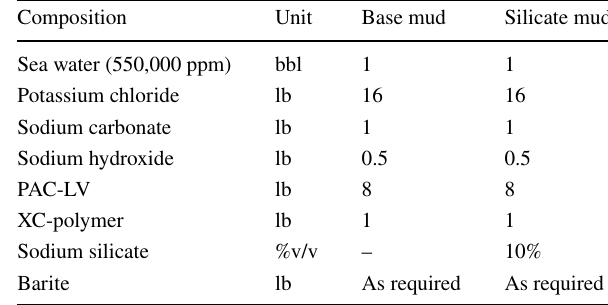
Table 1 Materials and components for the preparation of for each drilling fluid type